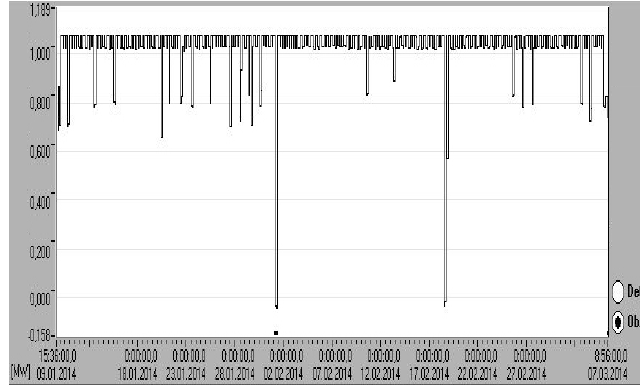
Fig. 4. Course of entire active power over the whole period observed at the location of BS 1